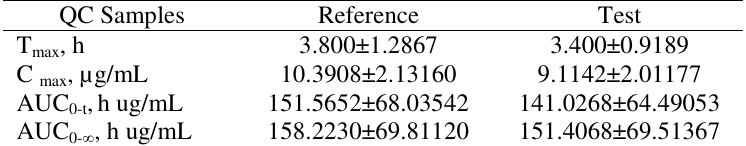
Figure 5. Linear mean plasma concentration–time profile for fenofibric acid fed study (145 mg tablet) Table 4. Summary results of pharmacokinetic parameters for fenofibric